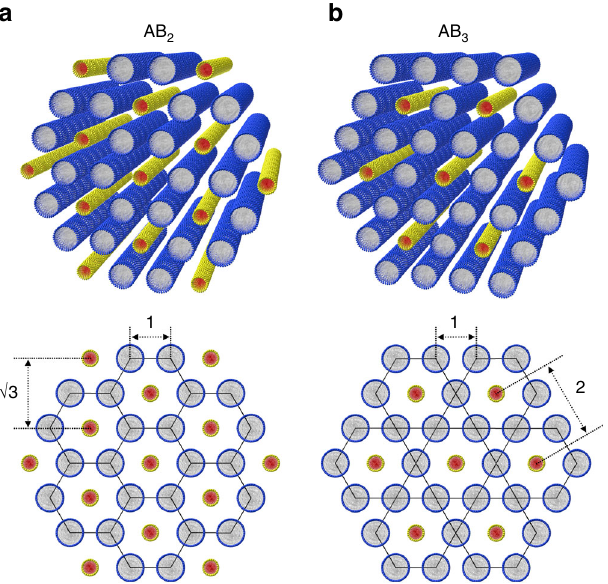
Fig. 6 Schematics of AB 2 and AB 3 binary superlattices. Schematics for a the AB 2 type intercalated hexagonal binary superlattice in which a hexagonal array of p -C n TVB is embedded in a honeycomb lattice of C 12 E 5 cylinders, and b the AB 3 type intercalated hexagonal binary superlattice in which a hexagonal lattice of p -C 10 TVBs is embedded in a kagome lattice of C 12 E 5 cylinders. In the AB 2 type structure formed by p -C 10 TVB/C 12 E 5 /water (10/ 45/55), the distance between the nearest neighboring C 12 E 5 cylinders and the distance between the nearest neighboring p -C 10 TVBs are 5.60 and 9.71 nm, respectively, making 1: √ 3 ratio. The corresponding distances in the AB 3 type structure formed by p -C 10 TVB/C 12 E 5 /water (5/45/55) are 5.72 and 11.44 nm, respectively, making 1:2 ratio